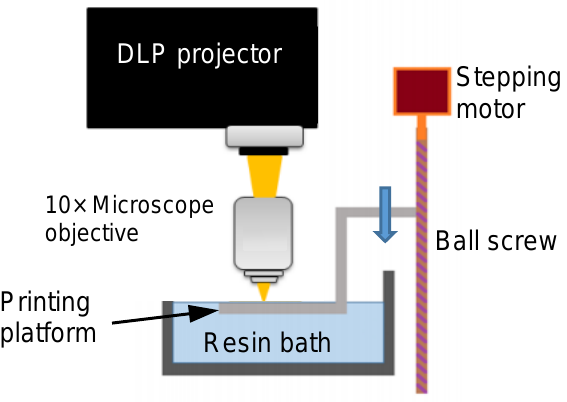
Figure 1. The digital light processing (DLP) printing system.